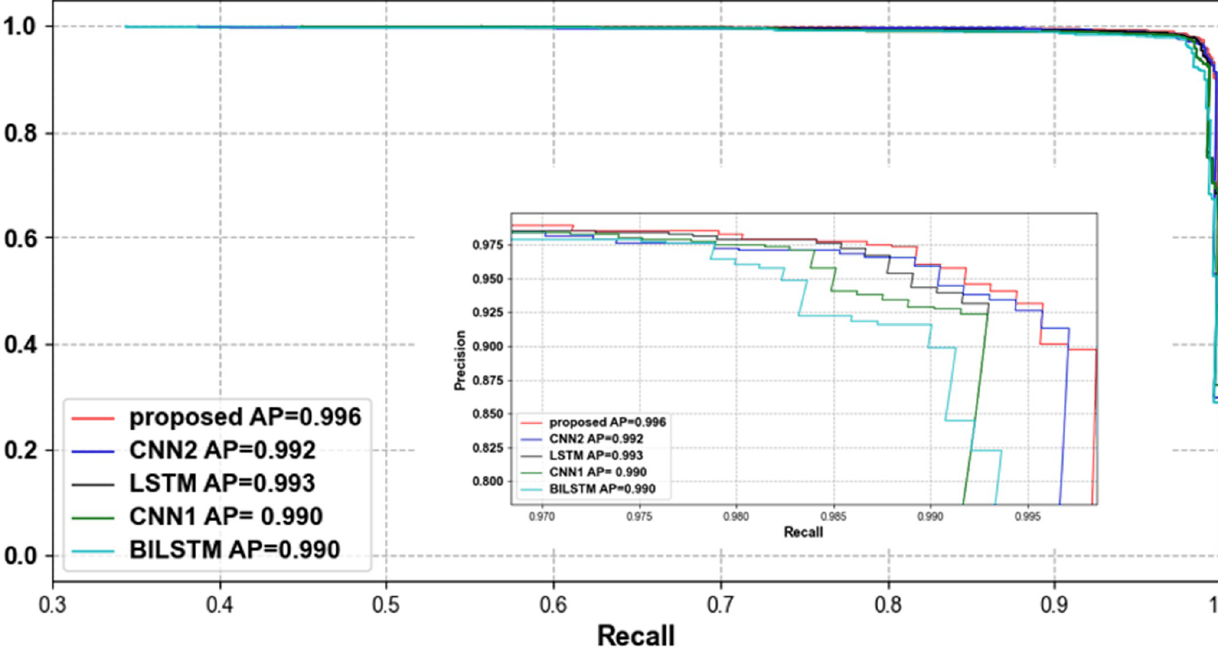
Fig 12. PR curve of each classification model when CR =